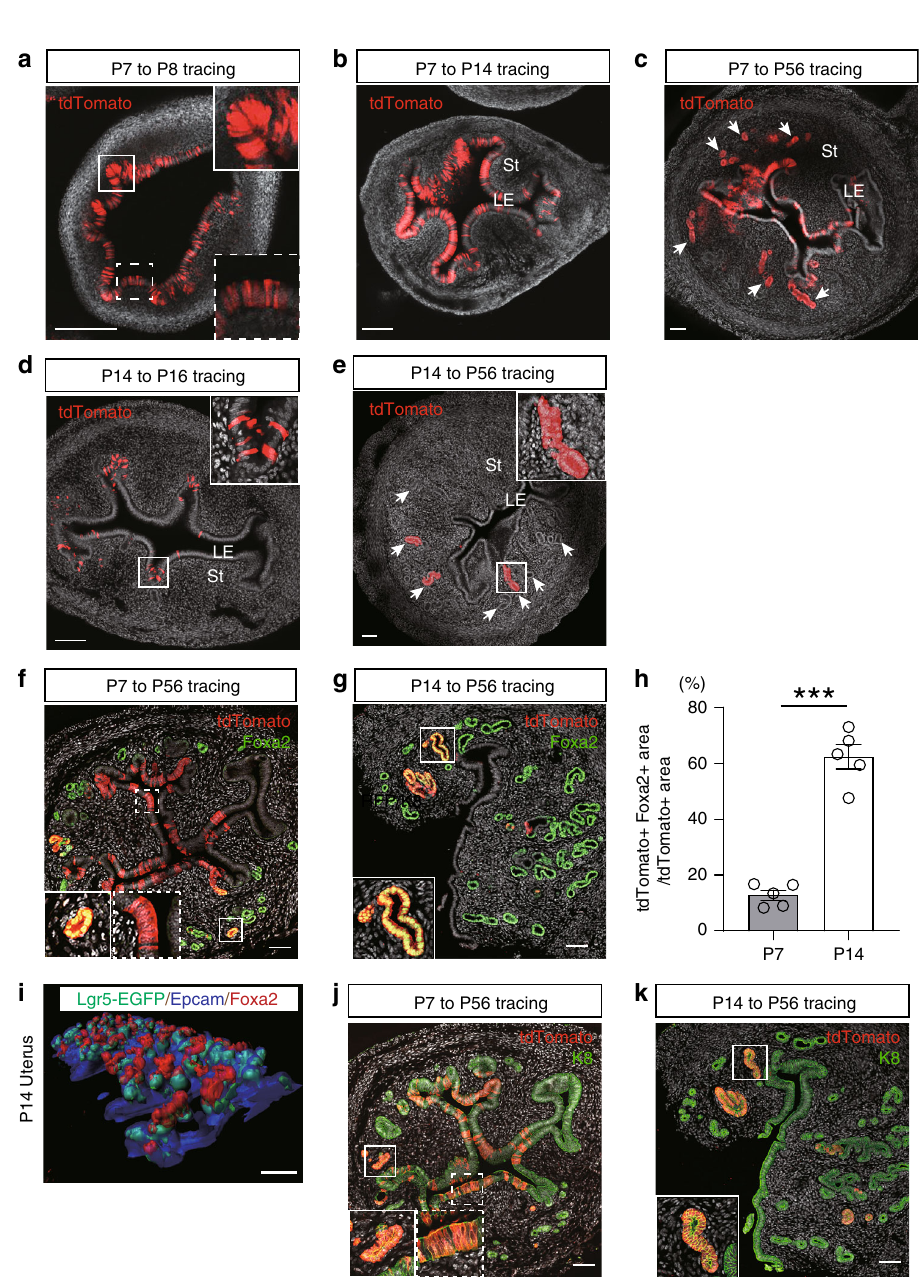
Fig. 4 Pre-pubertal Lgr5 + populations are stem/progenitor cells for the developing uterus. a – e Endogenous tdTom fl uorescence in Lgr5-2A-CreERT2; R26- tdTomato mouse uterus traced from P7 to P8 a , P7 – P14 b , P7 – P56 c , P14 – P16 d , and P14 – P56 e , respectively. Insets with solid and dashed lines indicate developing glandular epithelium (GE) and luminal epithelium (LE), respectively. White arrows indicate differentiated GE. St Stroma. f , g Co-IF for tdTom and Foxa2 in Lgr5-2A-CreERT2; R26-tdTomato mouse traced from P7 to P56 f and P14 – P56 g . h Comparison of the percentage of Fox2 + cells within tdTom + tracing units in P7 – P56 and P14 – P56 traced mice. Three independent fi elds from each mouse were analyzed. Data are represented as mean ± s.e.m. of the average of fi ve independent mice. Data were tested for signi fi cance using unpaired two-tailed t -test ( P = 9E − 05, *** P < 0.001). i 3D image of P14 Lgr5-2A- EGFP mouse uterus, co-stained for Epcam and Foxa2. j , k Co-IF for tdTom and K8 in Lgr5-2A-CreERT2; R26-tdTomato mouse traced from P7 to P56 j and P14 – P56 k . Insets with solid and dashed lines indicate mature GE and LE, respectively. Scale bars, 100 μ